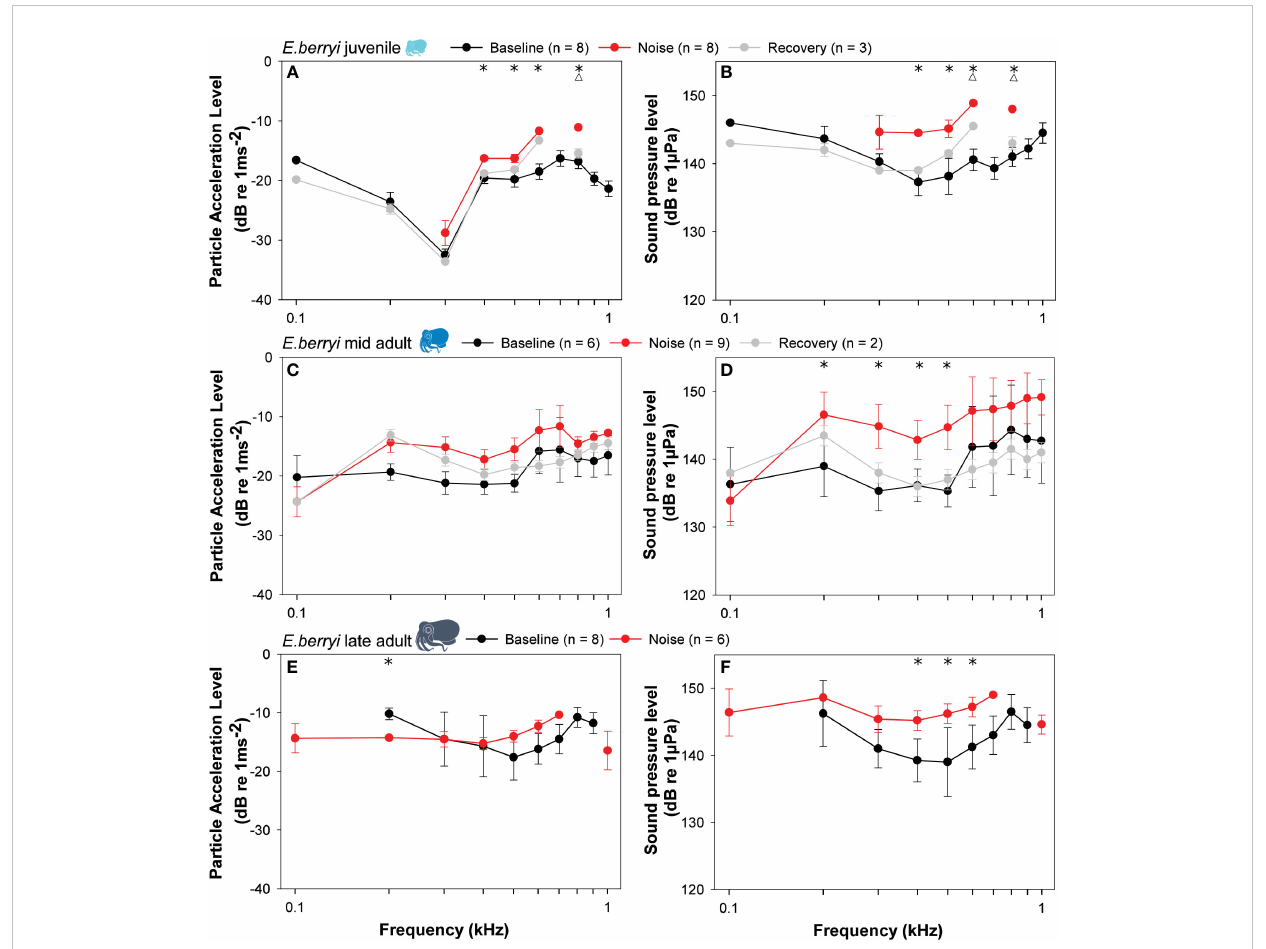
FIGURE 5 The thresholds of (A, C, E) particle acceleration level (dB re. 1 ms -2 ) and (B, D, F) sound pressure level (dB re. 1 µPa) needed to evoke an AEP response plotted against frequency (Hz) for three different aged hummingbird bobtail squid ( E. berryi ) groups (A, B) juveniles; (C, D) mid-adult and (E, F) late adult. Data are plotted as mean ± SD. Statistical difference (Holm-Sidak< 0.05) in sensitivity at that frequency indicated by asterisks (*) between sound exposure and baseline, and triangles ( D ) between sound exposure and